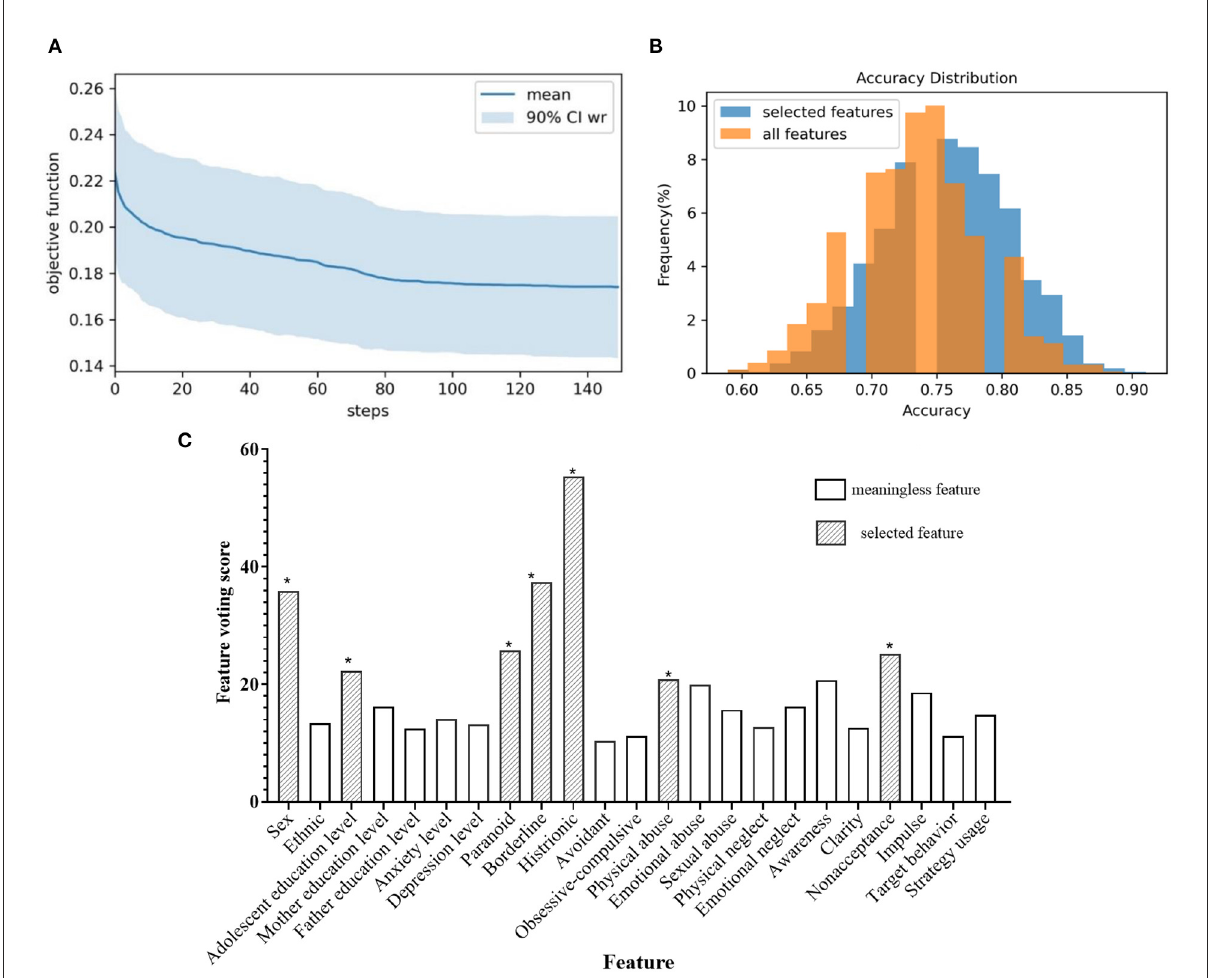
FIGURE5 (A) Objective function of the training process for identifying NSSI; (B) The distribution of classification accuracy for identifying NSSI; (C) Feature voting for identifying NSSI; *selected